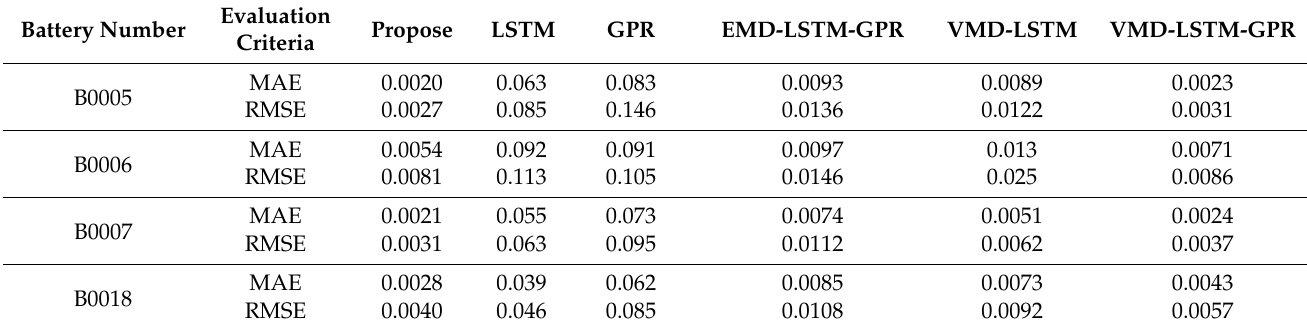
Table 5. Comparison of errors between the algorithm in this paper and the other five